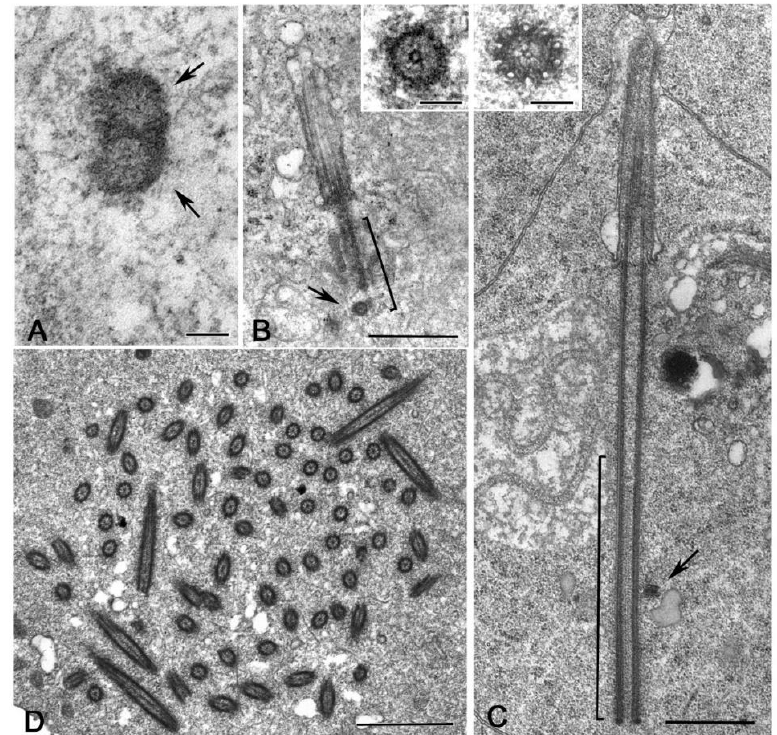
Figure 6. Abnormal centriole duplication in insect male germ cells. ( A ) Detail of two procentrioles (arrows) in the primary spermatocytes of the butterfly Pieris . Procentrioles (arrows and insets) in young spermatids of the fruit fly Drosophila ( B ) and the ladybird Adalia ( C ) brackets outline the extension of the centrioles. ( D ) Multiple centrioles in the spermatids of the termite Mastotermes . Bars: A, insets B and C, 100 nm; B,C, 500 nm; D, 1